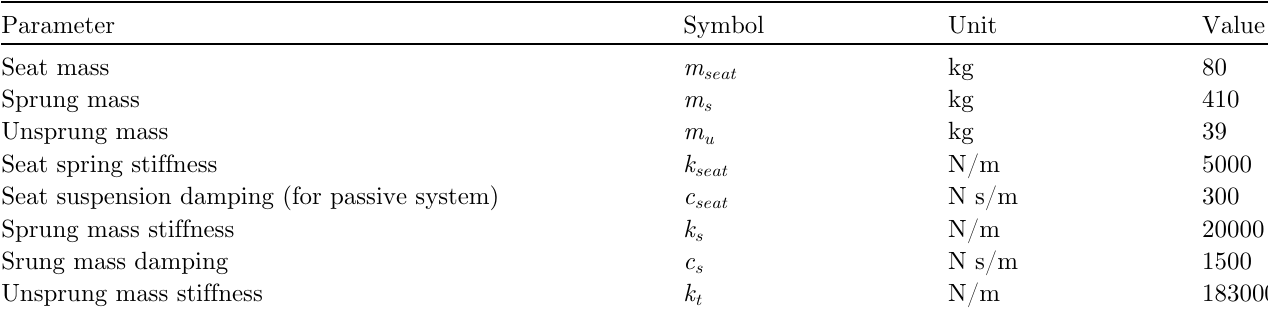
Table 1. 3-DOF seat suspension system parameters.